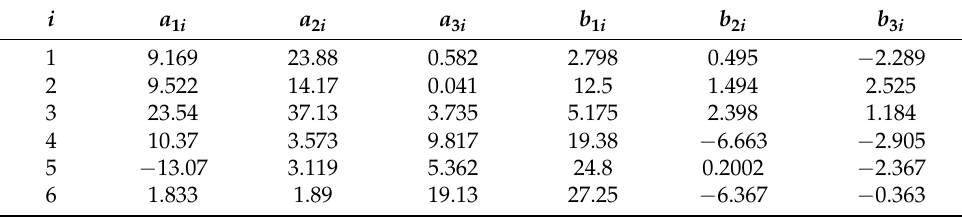
Table 2. Fitting parameters of thigh and calf swing angles.